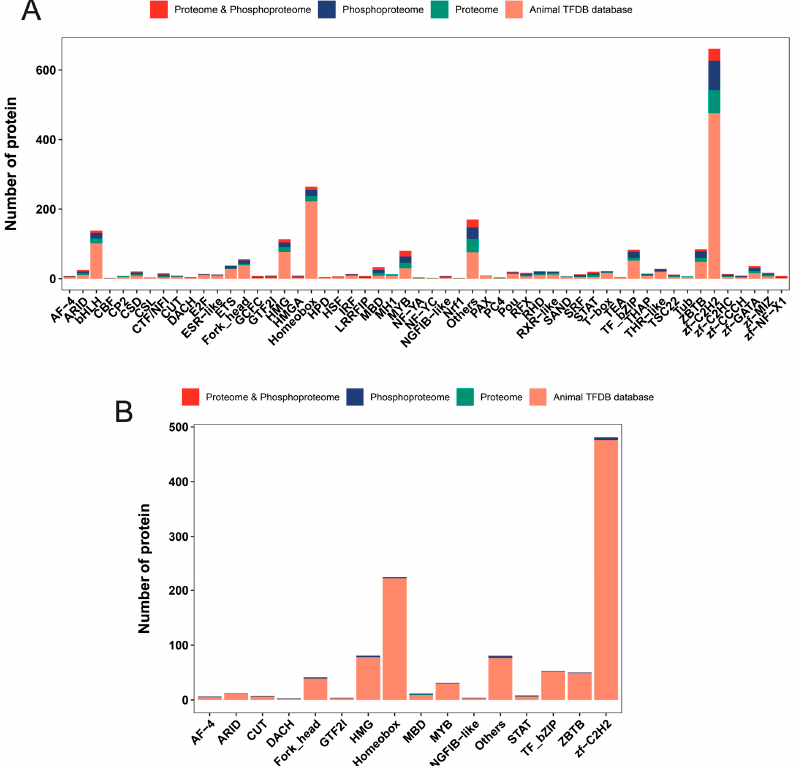
Figure 9. Distribution of transcription factor annotations in the two omics profiles and rat databases. ( A ) Overlap statistics between transcription factors in each transcription factor family and identified proteins in two omics ( B ) Overlap statistics between transcription factors in each transcription factor family and differentially expressed proteins in two omics.